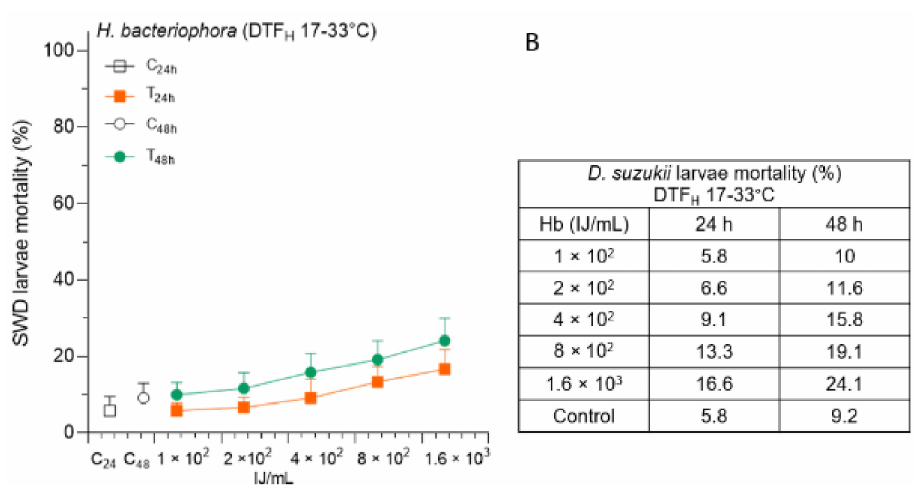
Figure 4. The efficacy of Heterorhabditis bacteriophora (Hb), at increasing concentrations, was evaluated as percentage mortality of Spotted Wing Drosophila (SWD) larvae (mean plus standard deviation), at 24 and 48 h, under constant temperature—CT 25 ◦ C ( A ), and high-temperature fluctuation—DTF H 17–33 ◦ C ( B ).